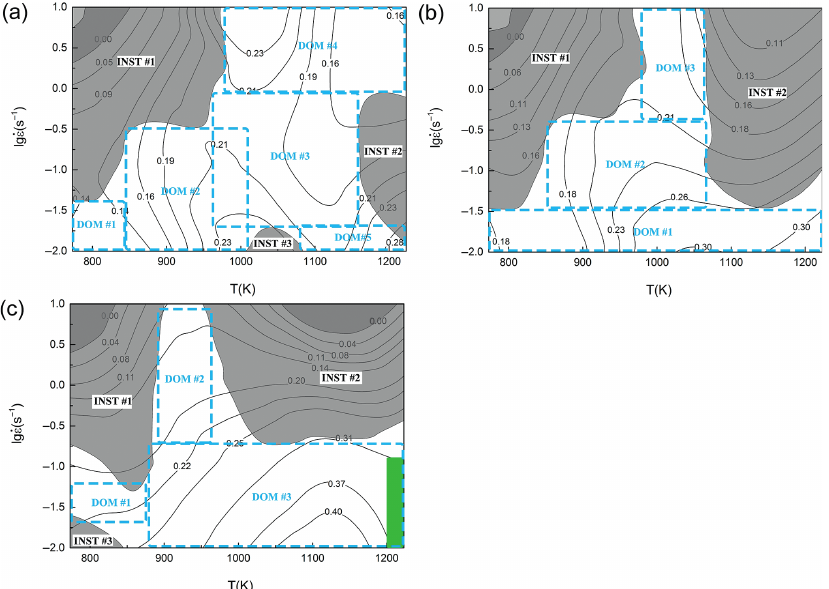
Figure 9: The processing maps of ultra-high strength steel BR1500HS at different strain value: (a) ε = 0.05, (b) ε = 0.10, (c) ε =